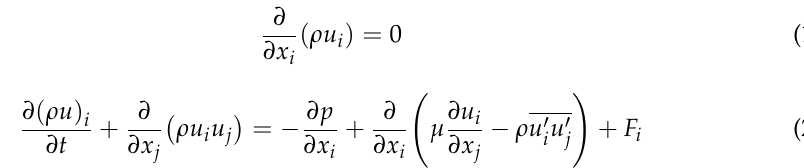
(c) Figure 2. View of mesh distribution around train and bridge: ( a ) general mesh distribution; ( b ) refined mesh; ( c ) boundary layer mesh. 2.3. Overset Mesh When the effect of moving trains must be concerned, the sliding and remeshing meth- ods are frequently used in related research of numerical simulations [27–31]. However, a novel overset mesh technique, also called ‘Chimera’ or overlapping methodology, is ap- plied in this study for its advantages in problems dealing with multiple or moving parts, where the individual mesh of moving parts can be created independently with fewer con- straints to avoid that the parts have to fit together conformally or along non-conformal interfaces, which is useful for some complex and irregular moving bodies in the flow. In the case of overset meshes, the flow domain consists of two parts—a static background zone and one or more dynamic component zones involving moving parts. In the moving train case described in this study, the background zone that makes up the background mesh of the computational domain includes the bridge model and outer flow boundary face, and the train model is subjected to a component zone with a rectangular volume of air around it, as seen in Figure 3. The outer boundary of the component zone, an overlap- ping interface between two cell zones, is specified as the overset boundary condition to exchange the flow field information between two cell zones. The moving train effect is